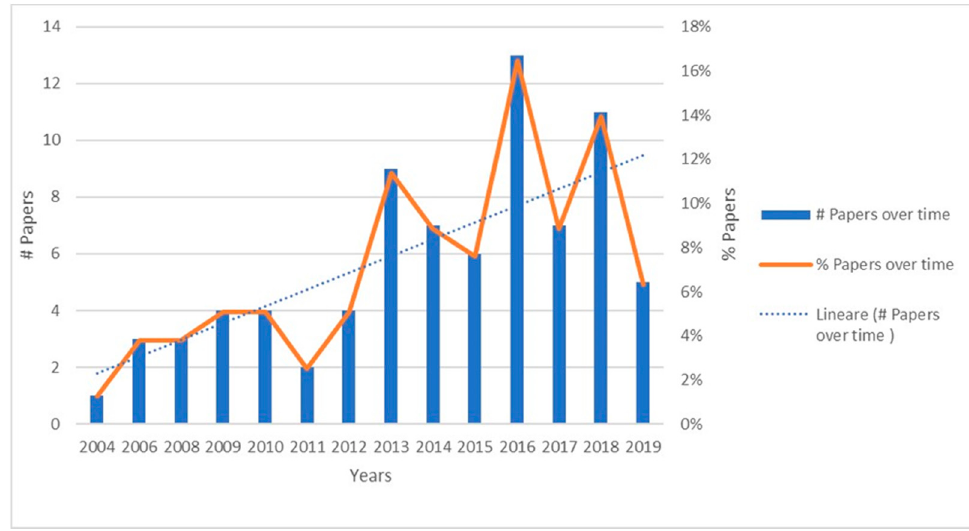
Figure 3. Publication trend by year.